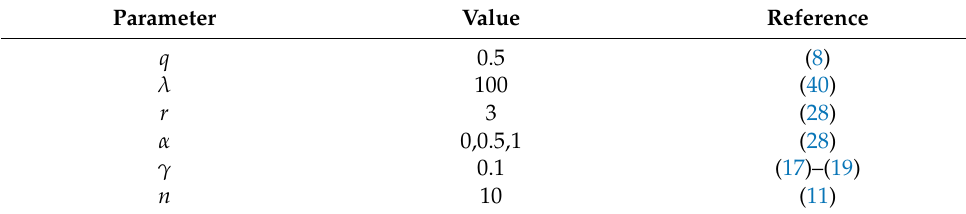
Table 2. Control